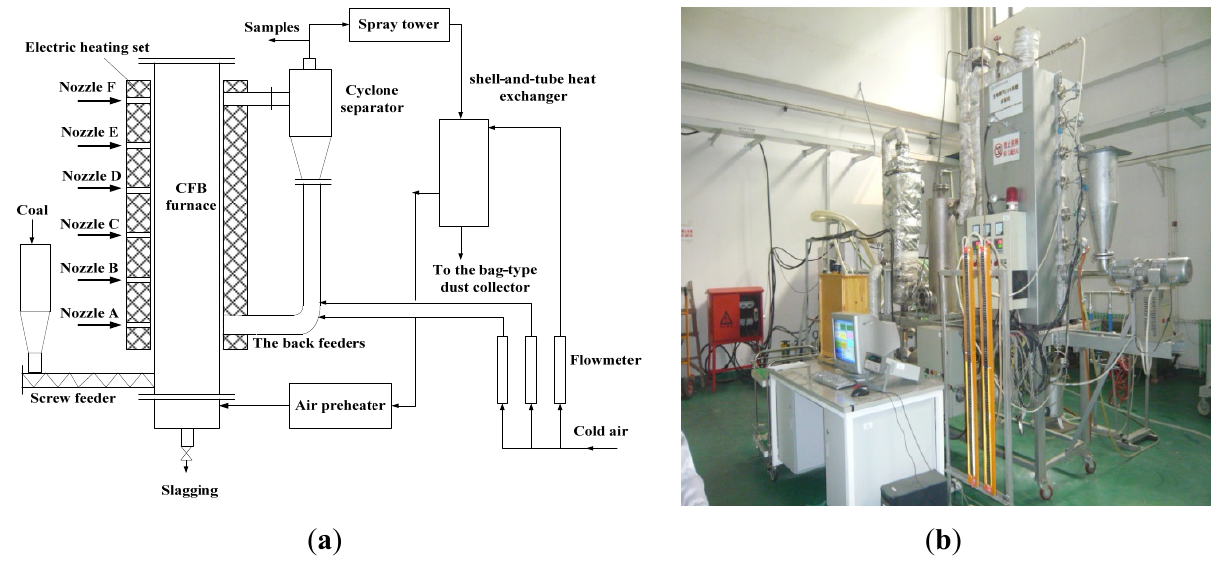
Figure 2. Circulating fluidized bed system. ( a ) Flow diagram; ( b ) Test bed.